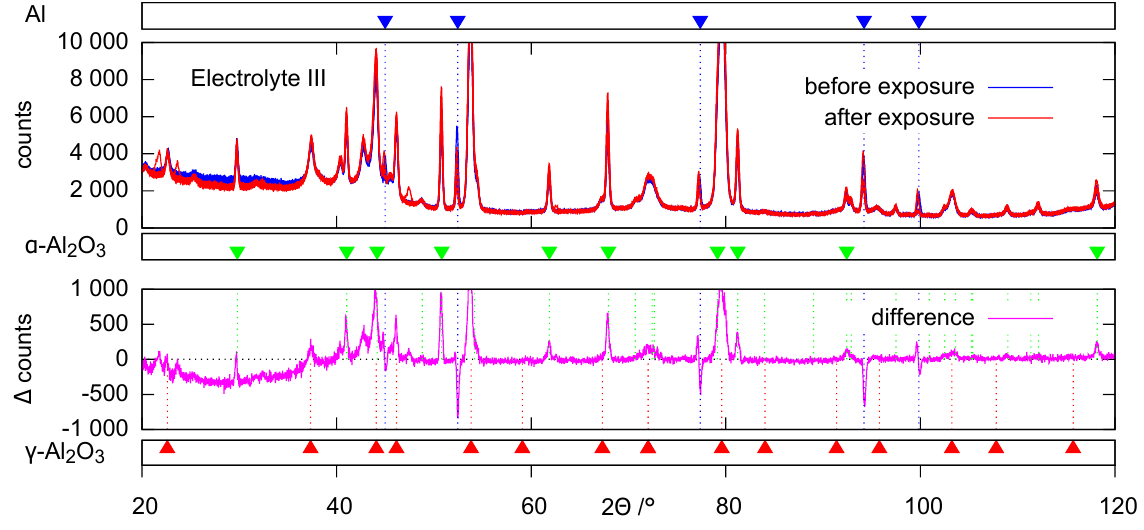
Figure 10. XRD diffractograms of the five PEO-coated samples exposed to electrolyte III before (blue) and after (red) the exposition experiments as well as the average difference graph (purple).